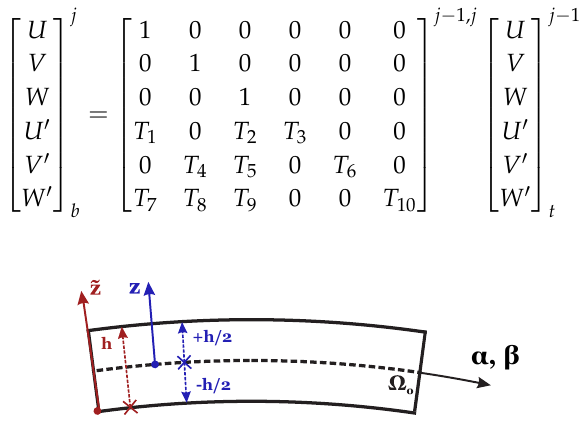
Figure 2. Thickness coordinates for the generic shell